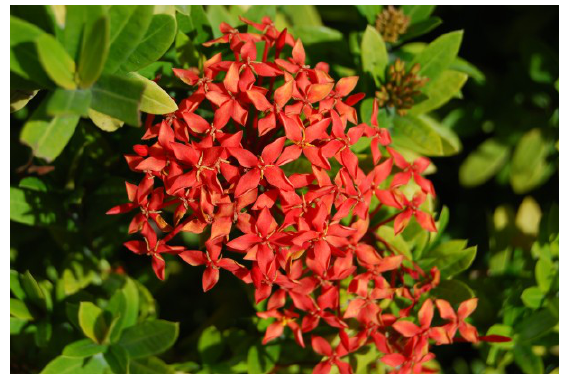
Figure 5. Ixora coccinea